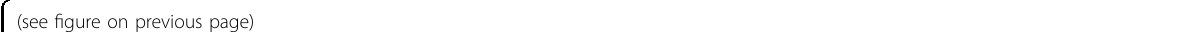
Fig. 4 BTF3 transcriptionally upregulates the expression of RFC family genes in prostate cancer cells. a Heat map plot of differentially expressed genes involved in DNA replication, nucleotide excision repair and mismatch repair in siBTF3 transfected PC-3 cells or control cells. b Quantitative reverse transcription-PCR (qRT-PCR) analysis of the RFCs mRNA levels was conducted in cells as indicated. Data are shown as mean ± SD for three independent experiments (** p < 0.01, *** p < 0.001, **** p < 0.0001 by Student ’ s t -test). c qRT-PCR analysis of the RFCs mRNA levels was conducted in DU145-Tet-On-shBTF3 xenografted tumors treated with or without Dox for 22 days. ACTB was used as an endogenous control. Dox, Doxycycline, 2 mg/ml in drinking water. Data are shown as mean ± S.D. * p < 0.05, ** p < 0.01 (Student ’ s t -test). d The gene expression levels of BTF3 and RFC family genes were examined in the TCGA prostate cancer datasets ( n = 496). The gene expression levels are reported as log 2 (TPM + 0.001) and plotted as BTF3 gene expression over RFC family genes expression. Each dot represents an individual sample of human prostate tumor. Spearman ’ s correlation coef fi cient (r) and p -values were determined as indicated. e The RFC promoter luciferase reporter assay was perform e d in siNC or siBTF3 transfected HEK293T cells. pGL3-Basic, control vector; pGL3-RFC1/2/3/4/5, vectors carrying promoter sequence from RFC1, RFC2, RFC3, RFC4 and RFC5, respectively. Data are shown as mean ± S.D. n.s, not signi fi cant, ** p < 0.01, *** p < 0.001, **** p < 0.0001 (Student ’ s t -test). f , g Chromatin immunoprecipitation (ChIP) assay was performed by BTF3 chromatin immunoprecipitation followed by quantitative PCR for the RFC promoters in HEK 293T cells ( f ), PC-3 ( g , left panel) and DU145 ( g , right panel). Enrichment of RFC promoter region was normalized to the input. IgG was used as a negative control. Mean ± S.D. for three independent experiments is shown. * p < 0.05, ** p < 0.01, *** p < 0.001 (Student ’ s t